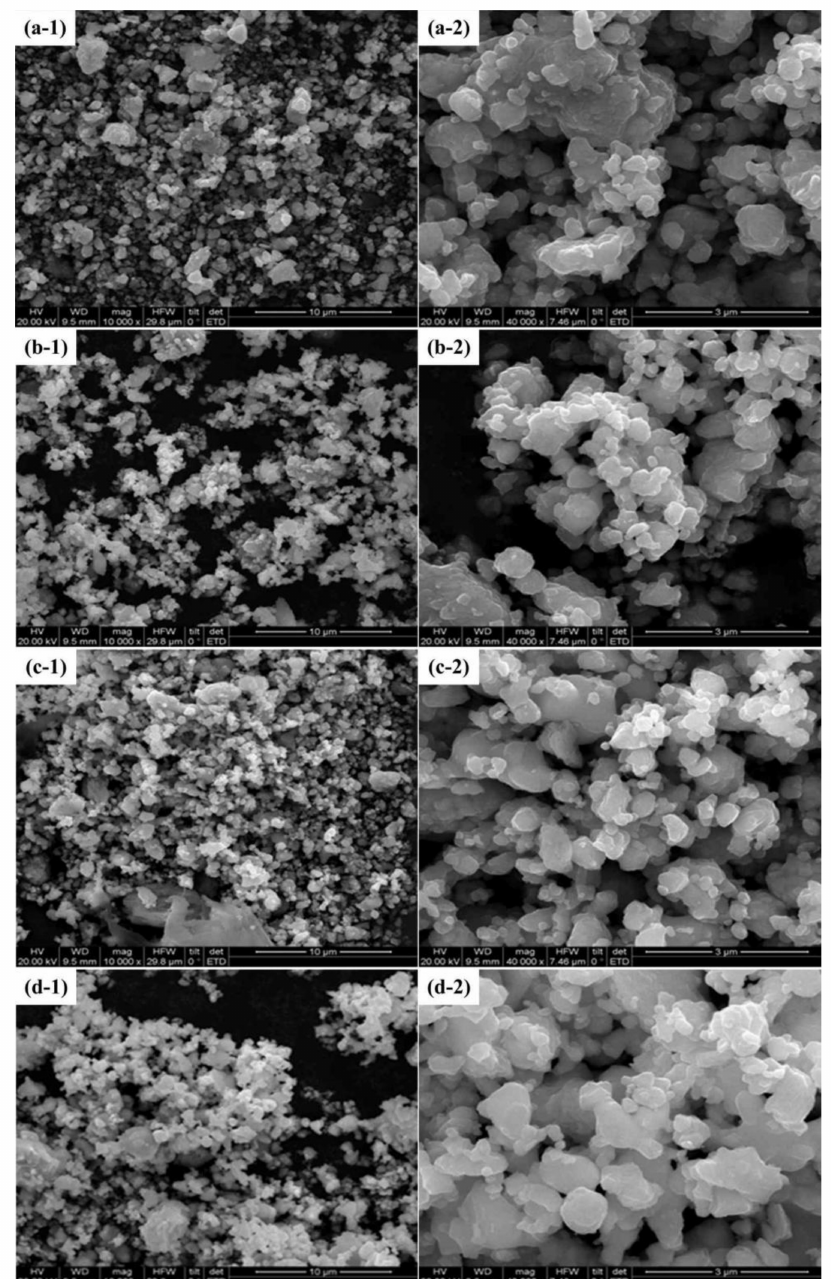
Figure 2. Microstructure of roasted products at different roasting times and temperatures: ( a-1 , a-2 ) and ( b-1 , b-2 ) denote the SEM images at a roasting temperature of 750 ◦ C, a roasting time of 120 min and 240 min, respectively; ( c-1 , c-2 ) and ( d-1 , d-2 ) denote the SEM images at a roasting time of 120 min, a roasting temperature of 850 ◦ C and 950 ◦ C,